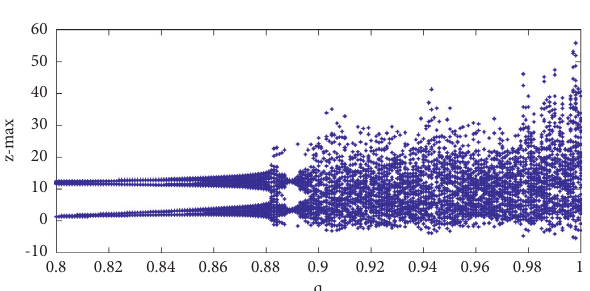
q � 0 . 99. In Figure 9, some of the phase portraits of hyperchaotic system (25) are depicted corresponding to initial conditions (0.11,0.11,0.11,0.11.0.11) by varying ini- tial coordinates of u ( 0 ) � 0 . 5 , and 1 . 0is made to run for 5 seconds with a time step of h = 0.001. The simulation result is shown in Figure 9.